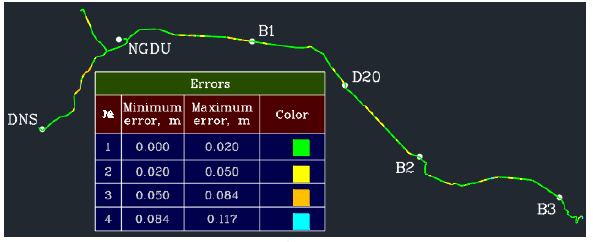
Figure 7. Error distribution for MLS data adjustment using check points every 1 km and control points every 4 km